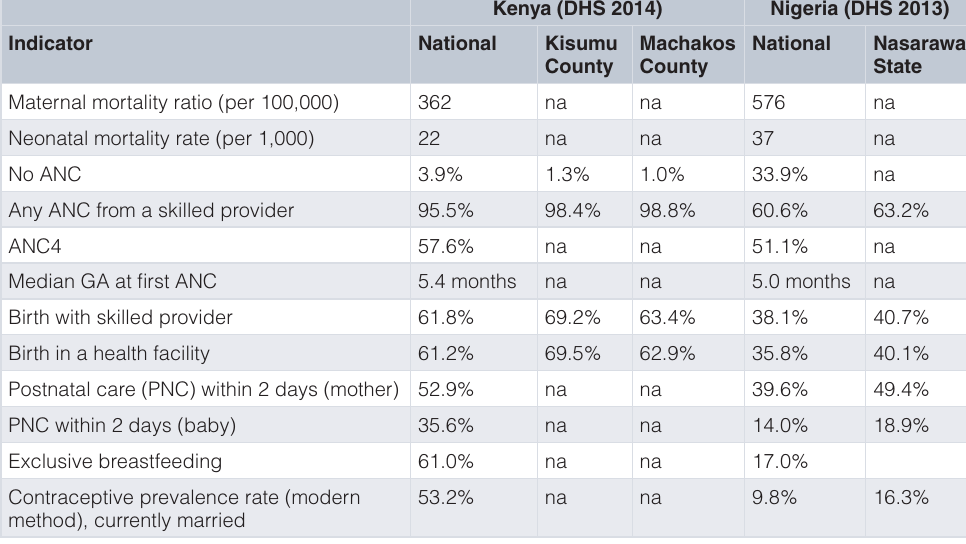
Table 1. Comparison of key MNCH/FP indicators for Kenya and Nigeria. Summary of key maternal newborn and child health/family planning (MNCH/FP) indicators based on DHIS2 data for Kenya (Kisumu and Machakos Counties) and Nasarawa,